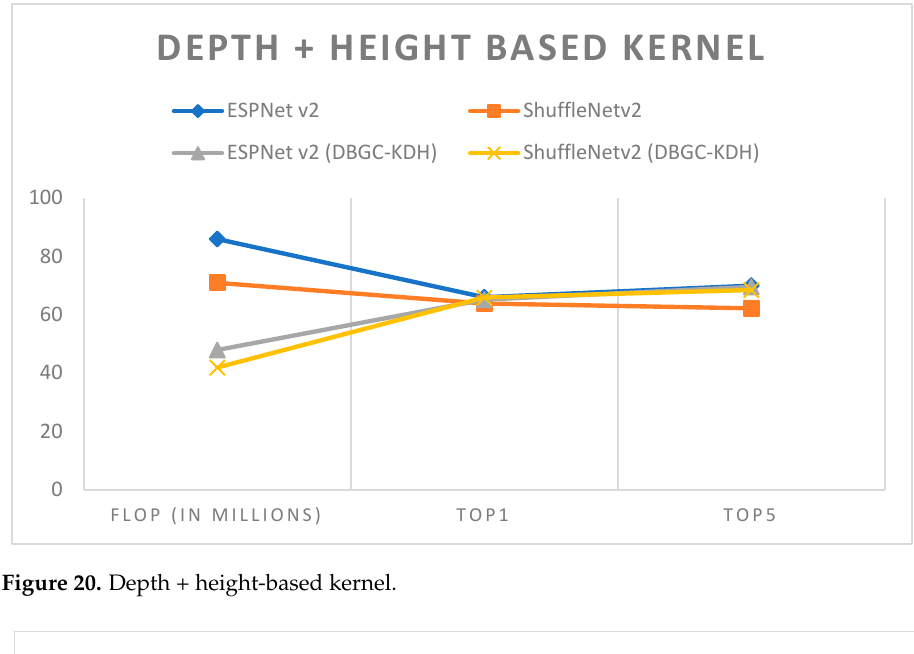
Figure 19. Depth+width-based kernel.